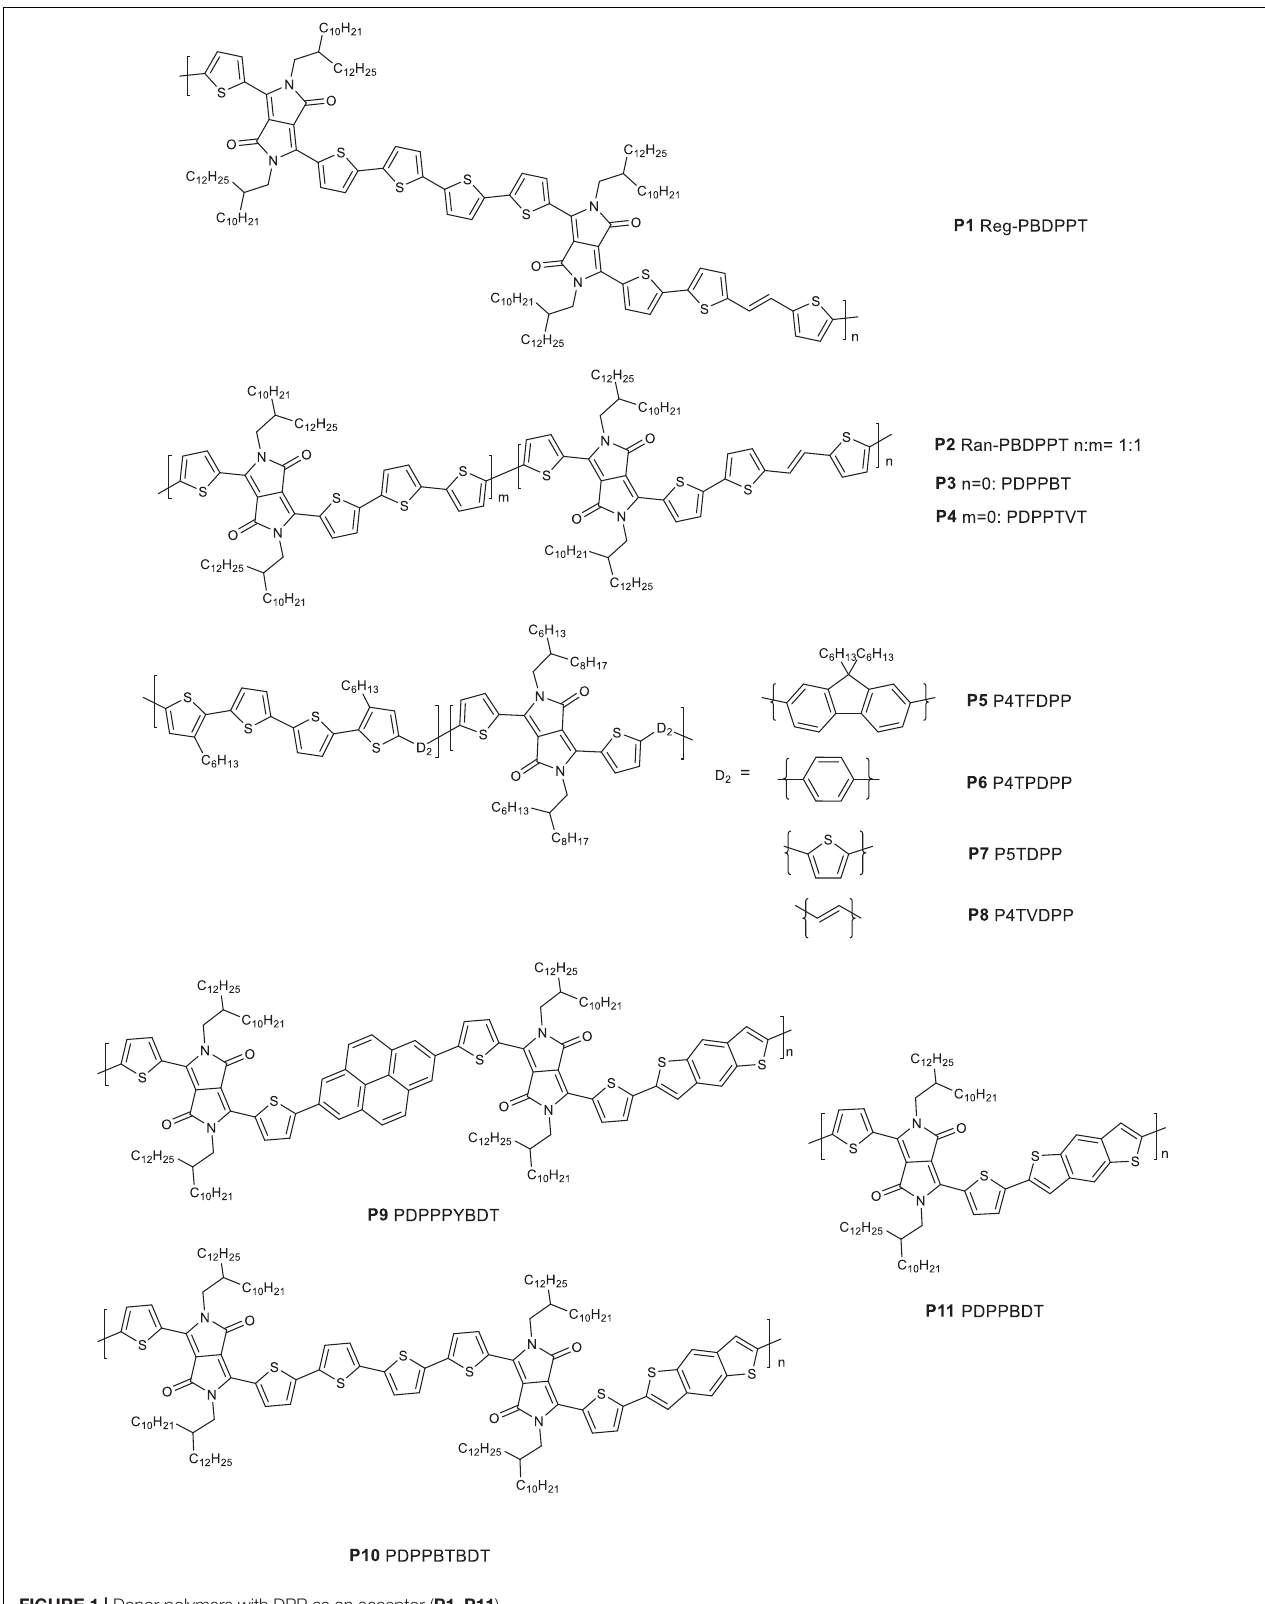
FIGURE 1 | Donor polymers with DPP as an acceptor ( P1 – P11 ).